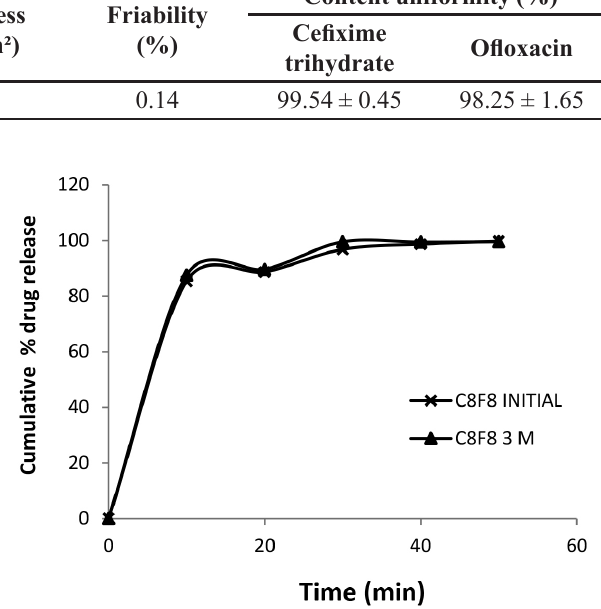
FIGURE 6 - In vitro drug release study of cefixime trihydrate from bilayer tablets before and after 3 months.